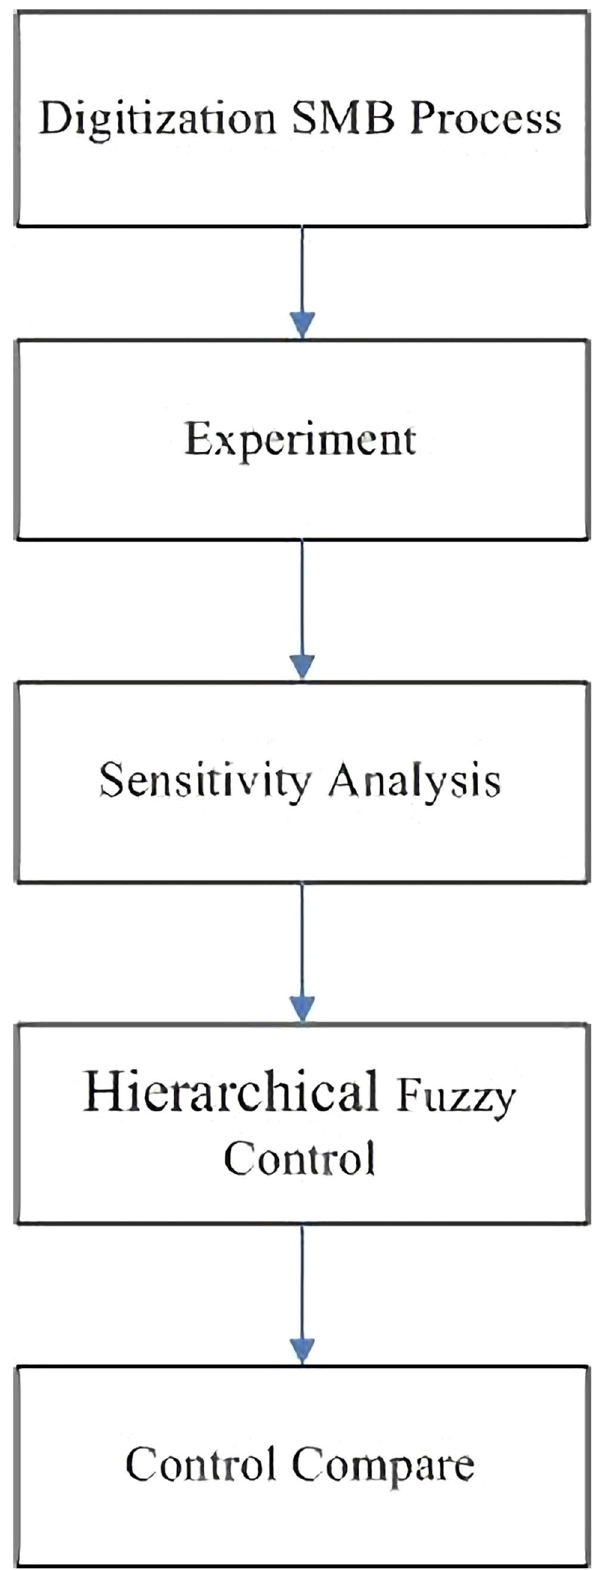
Figure 2. Research